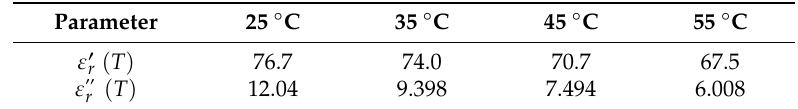
Table 2. Complex relative permittivity ε r = ε (cid:48) r − j ε (cid:48)(cid:48) r of water at 2.45 GHz in dependence of the